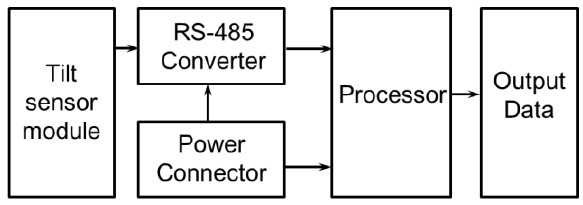
Figure 5. Block diagram of the processor module.